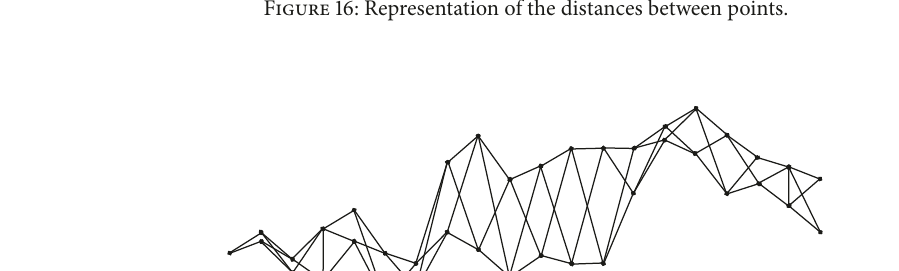
Figure 16: Representation of the distances between points.